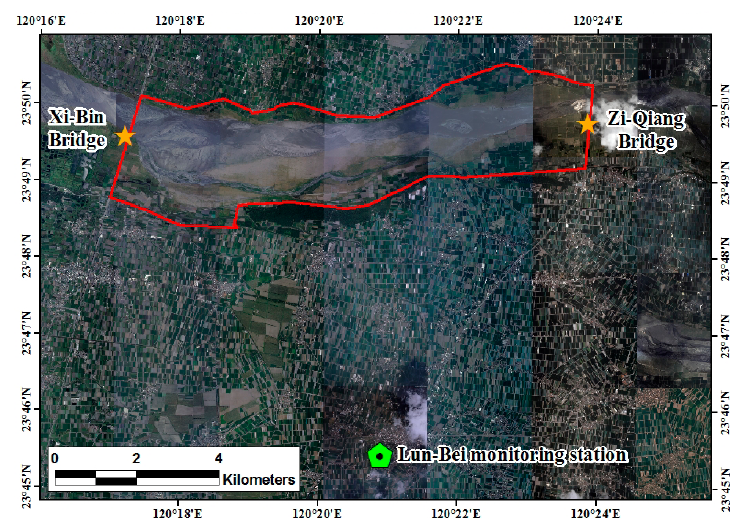
Figure 1. Location of study area and air quality monitoring stations.